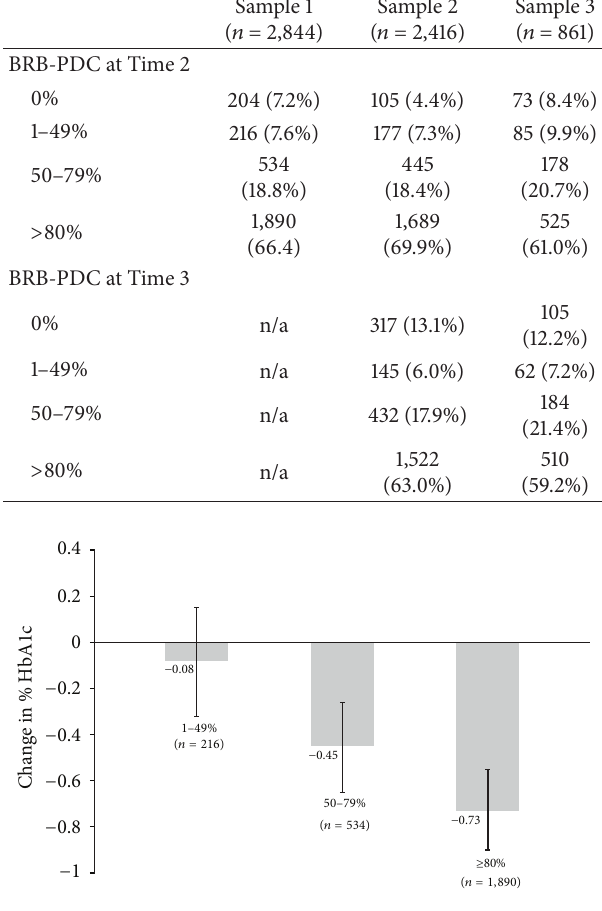
Figure1:PercentagepointchangeinHbA1cbeforeand6–12months after metformin initiation by category of Biologic Response Based Proportion of Days Covered where 0% is the reference group (Analysis 1). Error bars represent 95% confidence intervals.